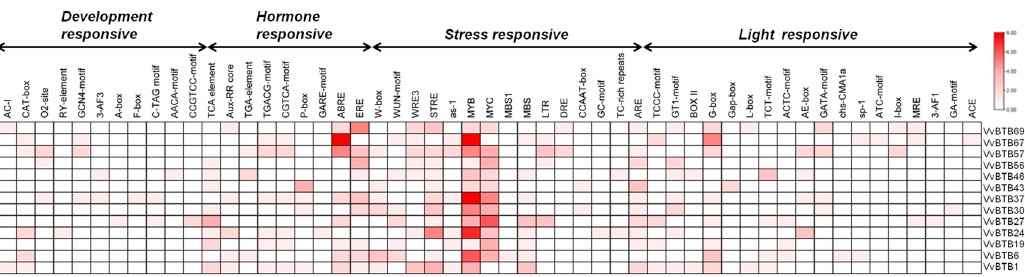
Figure 6. Cis -regulatory element analysis of the promoters of selected BTB genes. The color bar depicts the number of cis -regulatory elements.